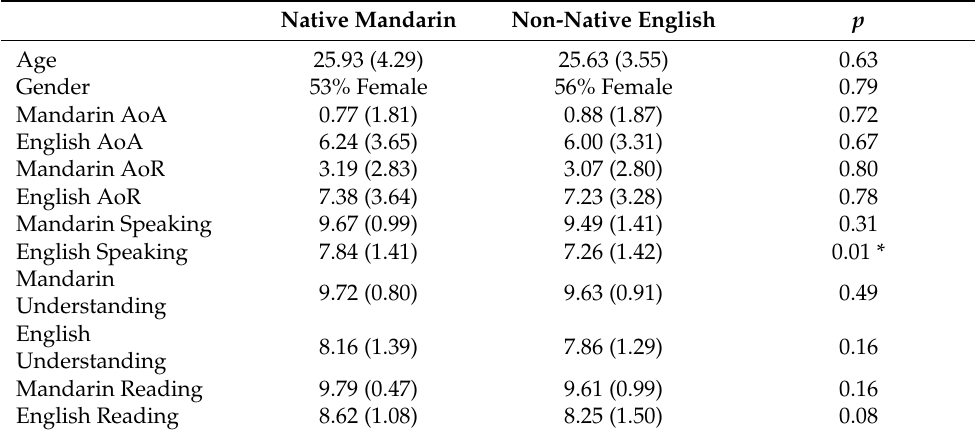
Table 1. Demographics of study participants by language